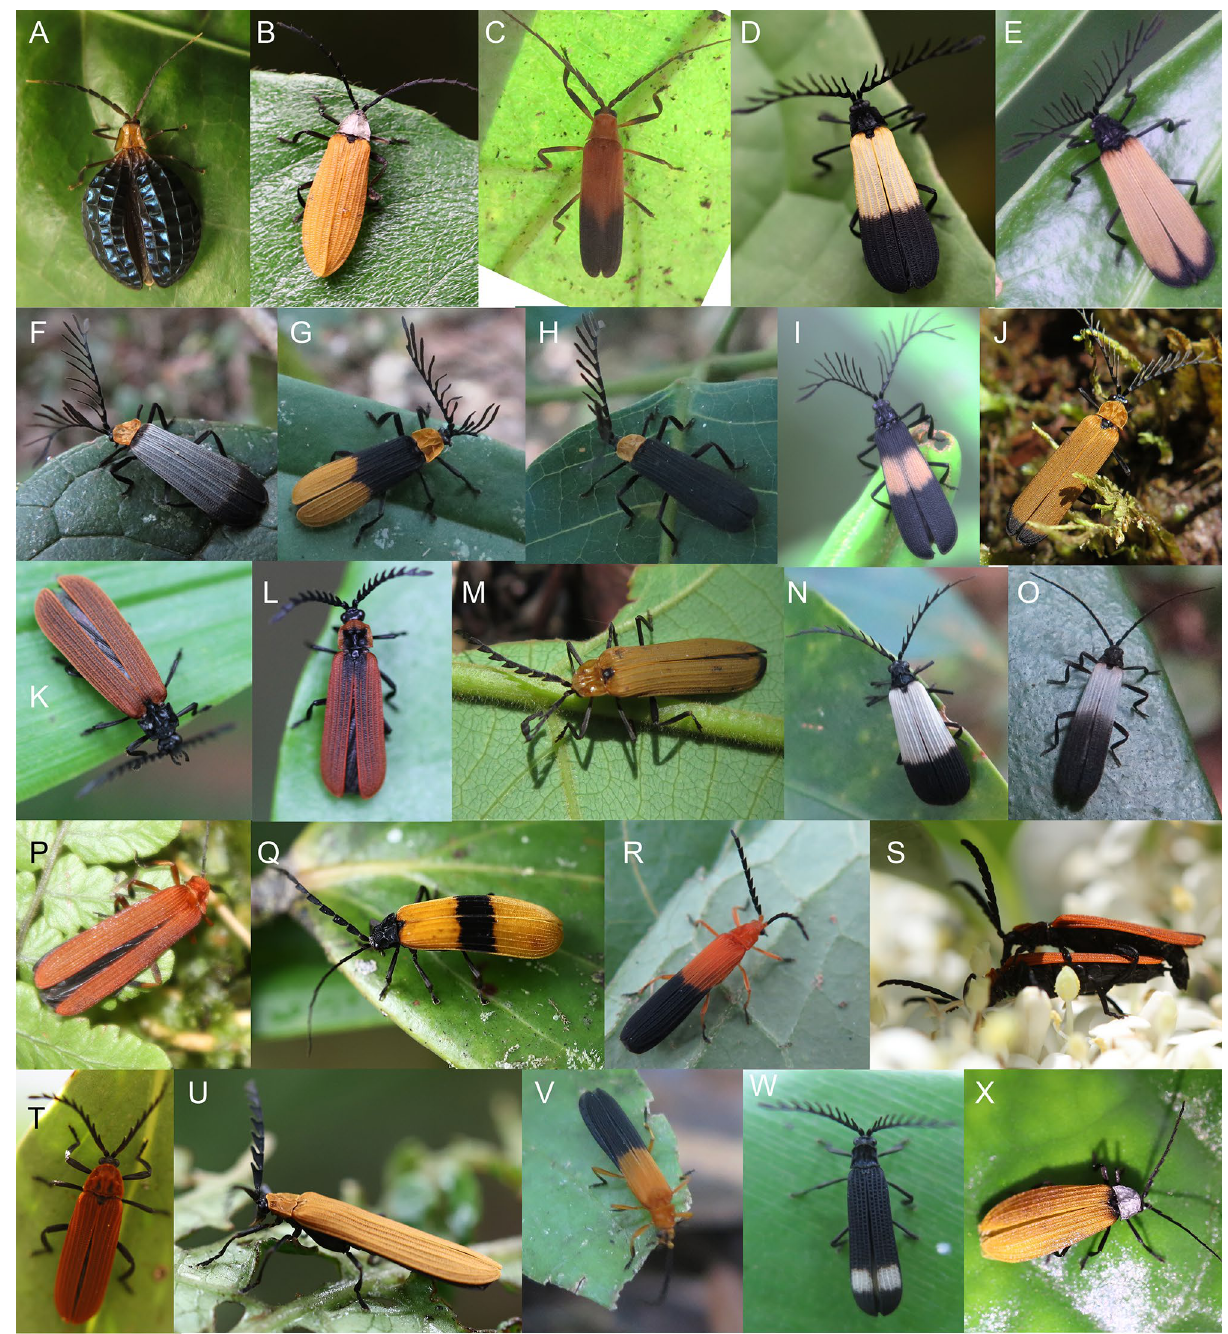
Figure 3. The examples of aposematic patterns displayed by net-winged beetles. ( A ) Broxylus pfeifferi , Sulawesi. ( B ) Diatrichalus sp., New Guinea. ( C ) Eniclases sp., New Guinea. ( D ) Flabellotrichalus sp., New Guinea. ( E – J ) Cladophorus spp., all from New Guinea. ( K , L ) Porrostoma spp., Queensland. ( M ) Porrostoma sp., New Guinea. ( N – V ) Metriorrhynchus spp., New Guinea. ( W ) Metriorrhynchini indet., New Guinea. ( X ) Enylus sp., New Guinea. All photographs by authors listed under the title of this